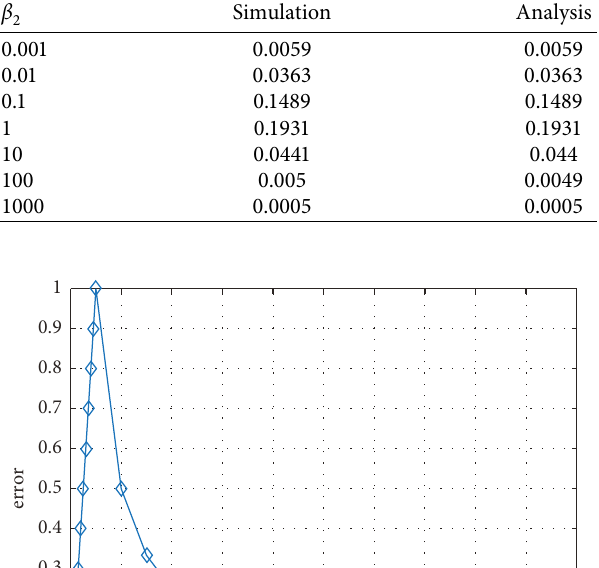
Figure 1: Statistical error versus β